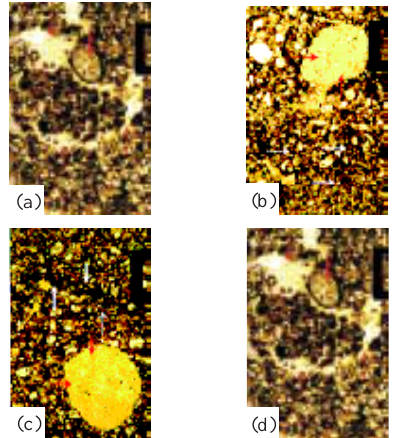
Figura 2. Densidade do solo nas diferentes posições de amostragem de um Latossolo Vermelho- Figura 3. Fotomicrografias de seções delgadas e orientadas de amostras de dois